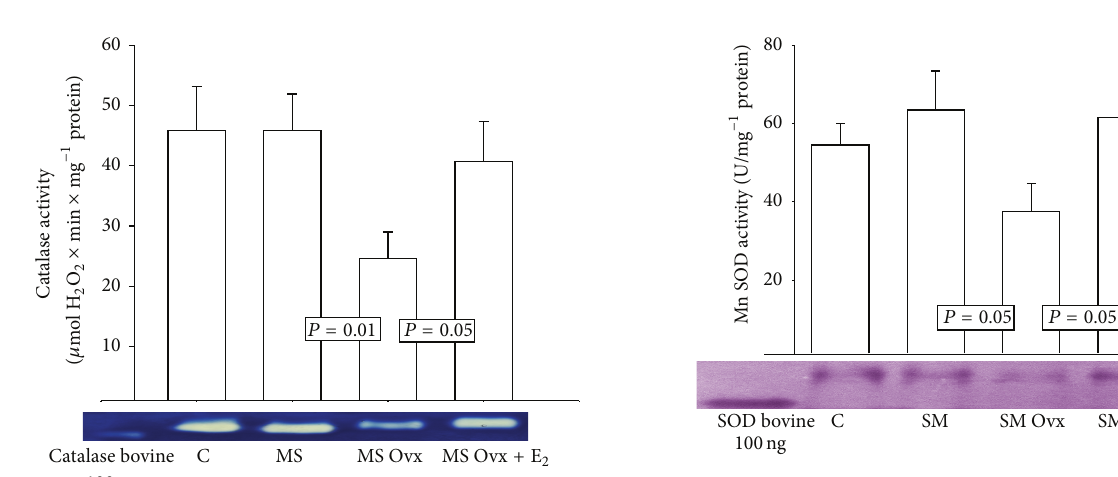
Figure 2: Effect of the estrogen removal and estradiol replacement on Mn SOD activity in adipocyte homogenate. Mn SOD: super- oxide dismutase manganese. Native-gel electrophoresis with 10% polyacrylamide. Data are means ± SE; 𝑛 = 8 in each group.